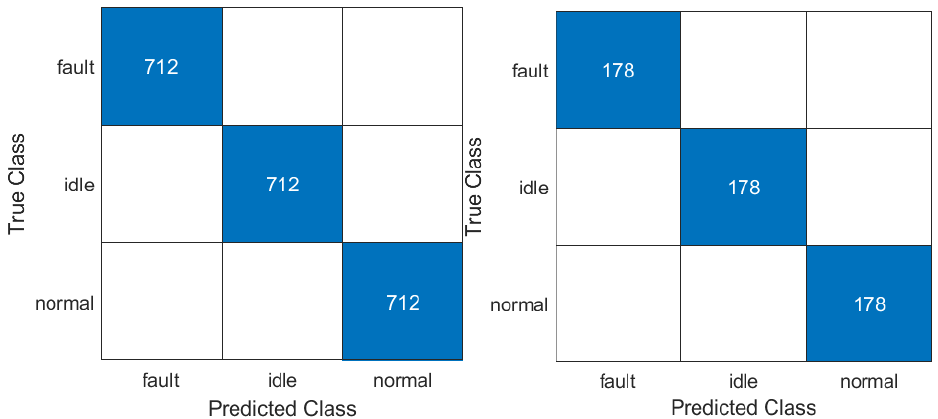
Figure 21. Confusion matrix of the trained ( left ) and tested ( right ) CNN classifier.